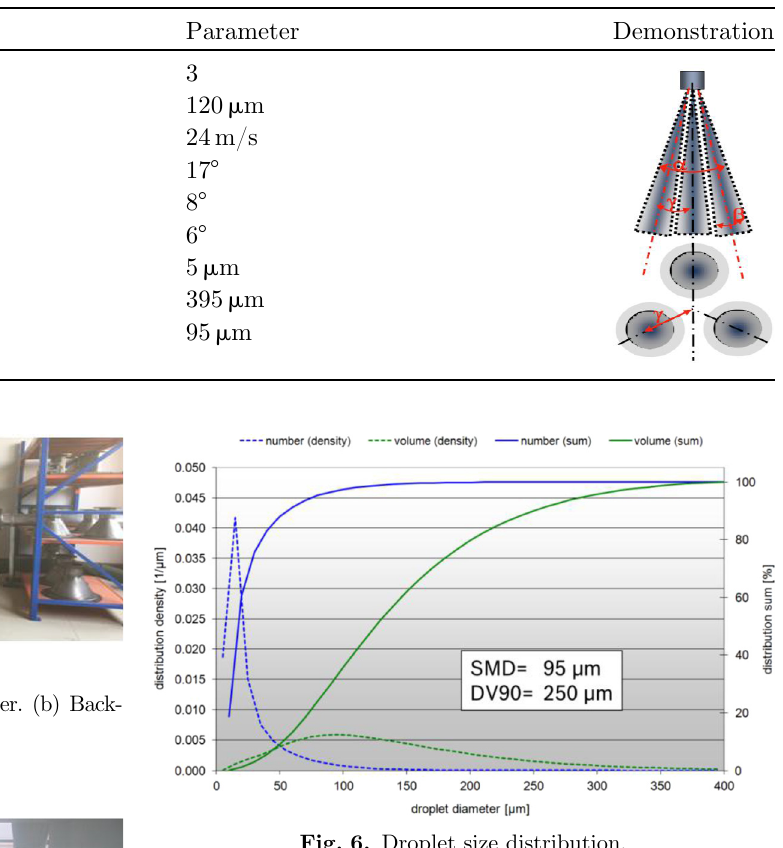
Table 1. Parameters of